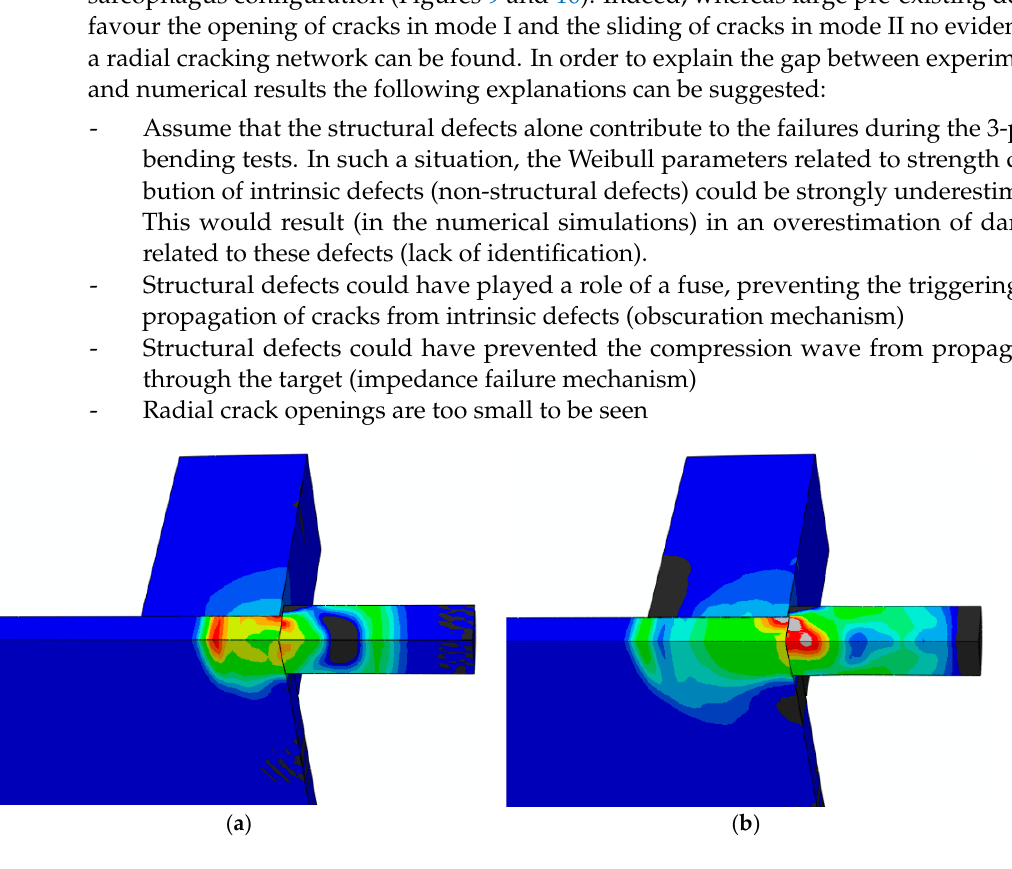
Figure 11. Field of hydrostatic pressure in [MPa] (cut view). ( a ) T = 4 µs and ( b ) T = 8 µs.